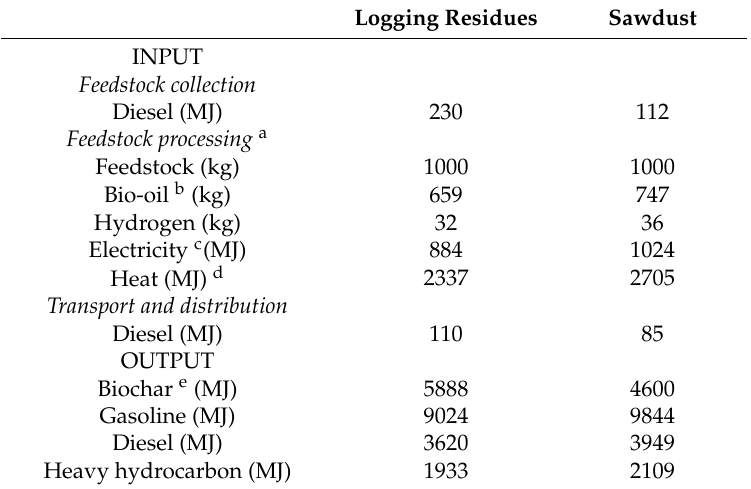
Table A2. Life cycle inventory of HVO production from 1000 kg feedstock